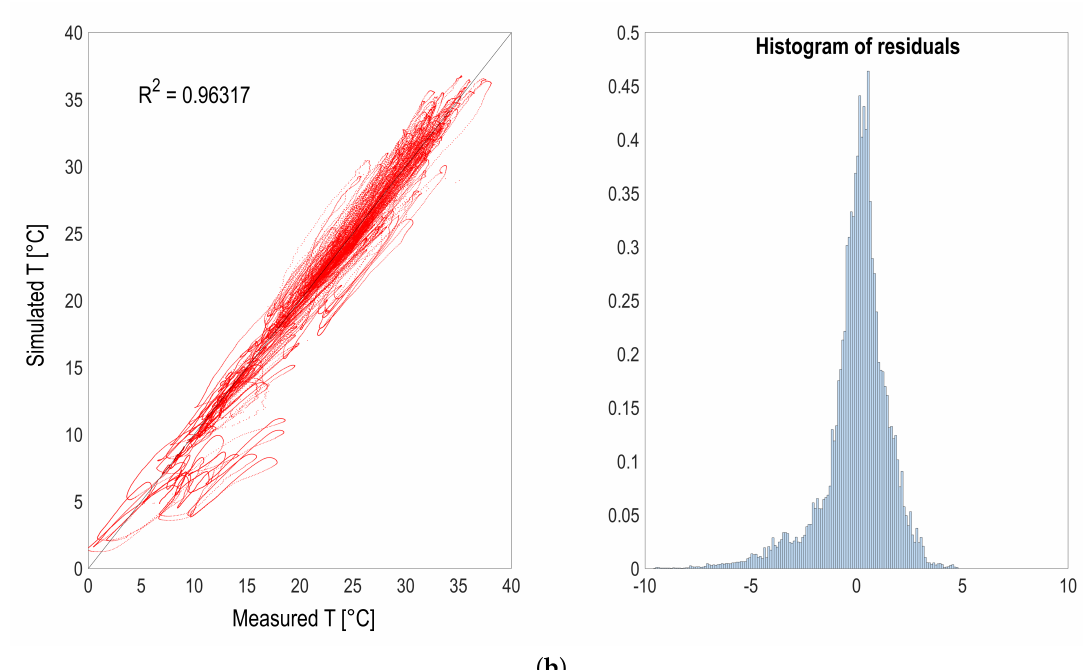
Figure 3. ( a ) Temperature predictions (red continuous line) compared with measurements (black dotted line) according to seasons. Absolute prediction error (orange continuous line) is also shown. ( b ) Temperature predictions vs. measurements (red dots) and histogram of residuals (blue